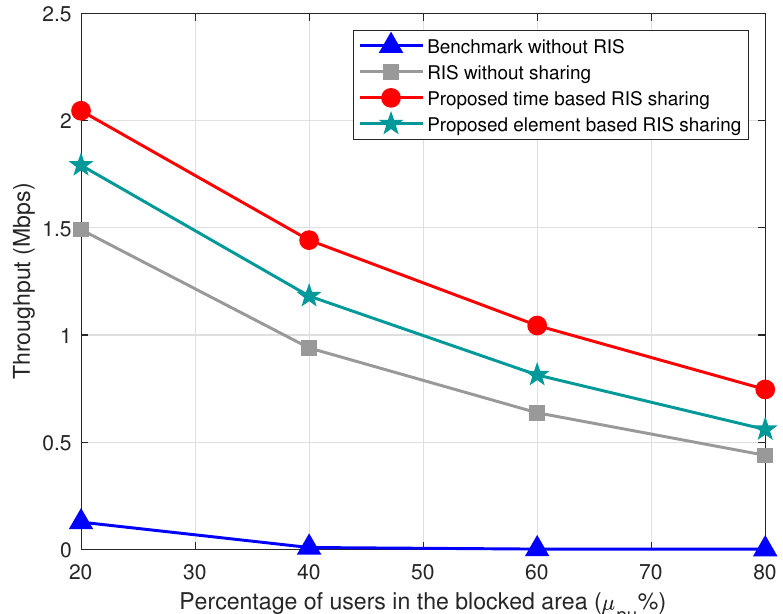
Figure 7. Variation of throughput with respect to µ pu users in the blocked area for µ u = 40, N = 40, µ b = 2, and α =